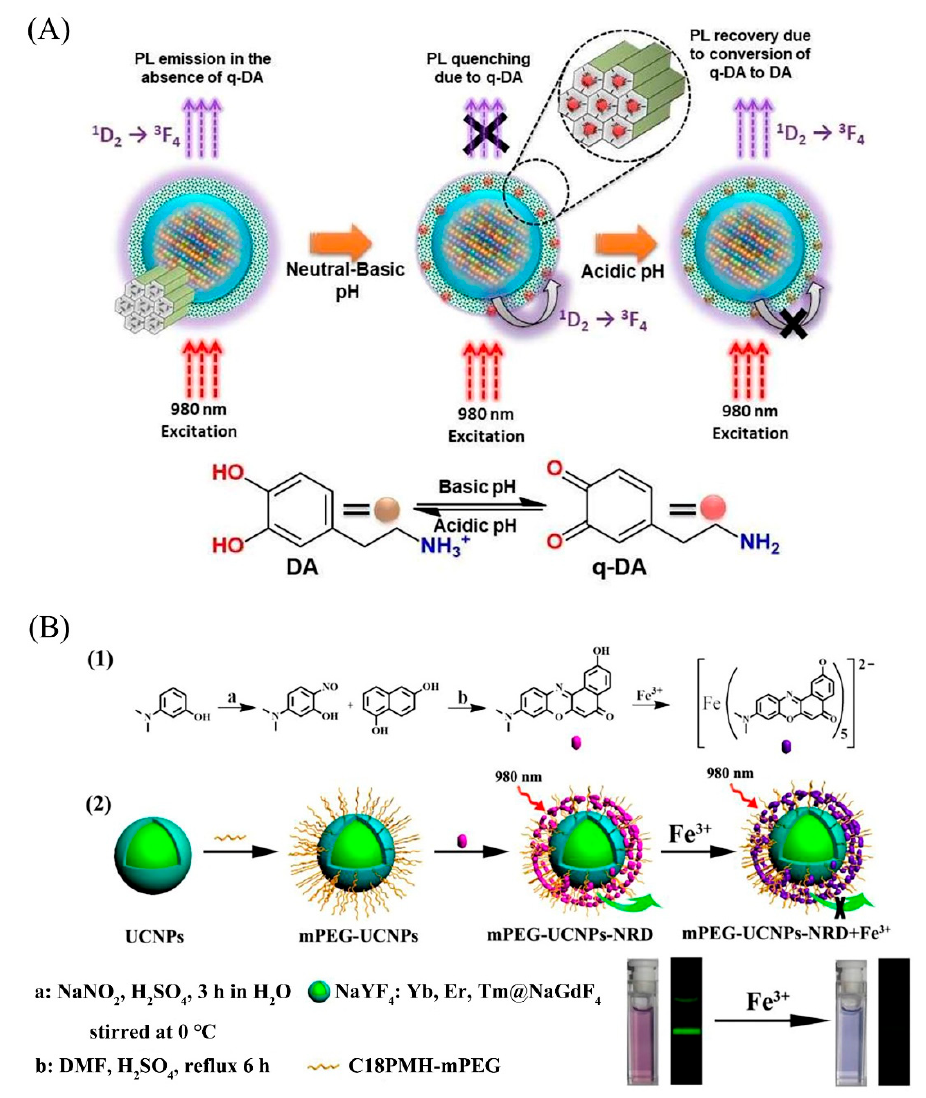
Figure 6. UCNPs in Analytical Application of Bioscience. ( A ) Concept of upconversion based nanoplatform (BCSU-MS) for dopamine (DA) and pH sensing. ( B ) (1) Illustration of the Synthesis of Nile Red Derivavite (NRD), (2) mPEG-UCNPs-NRD and Their Use for Detecting Fe 3+ Based on Change in UCL Emission. Reprinted with permission from [127,153]. Copyright 2019, John Wiley and Sons and 2016, American Chemical Society.